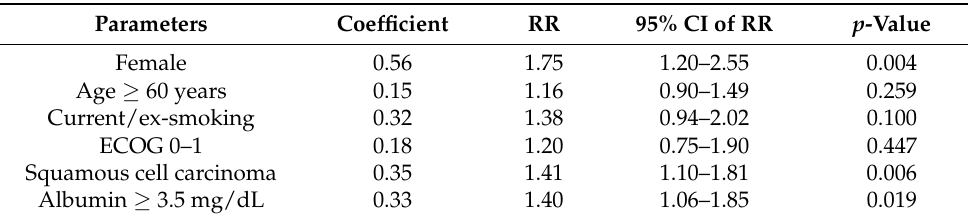
Table 2. Regression coefficient, risk ratio (RR), and 95% CI of selected parameters derived from risk regression after multiple imputation.